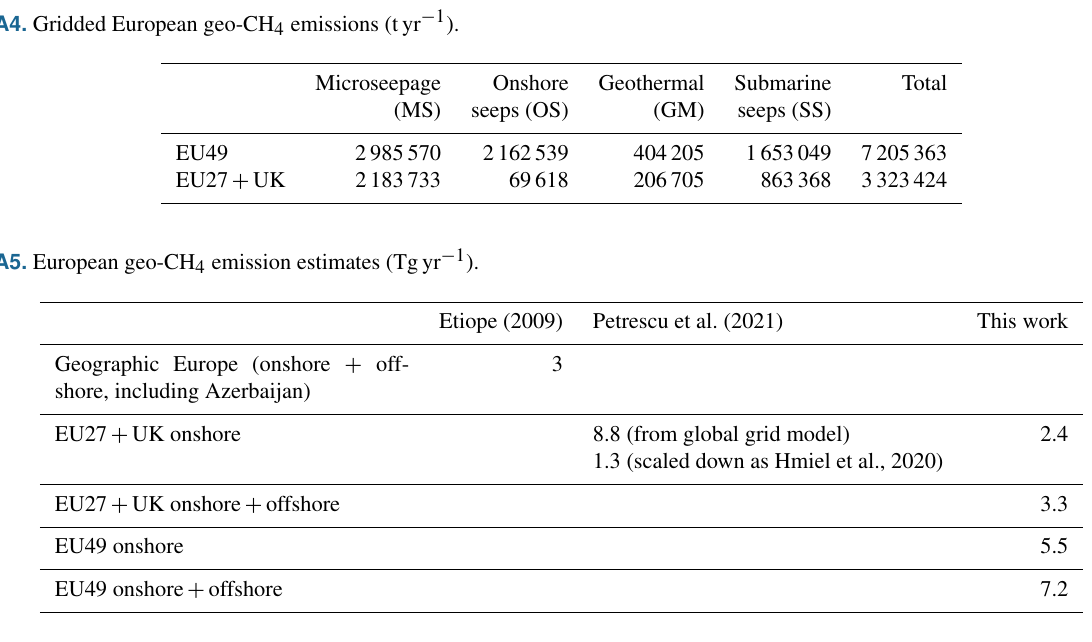
Table A4. Gridded European geo-CH 4 emissions (tyr − 1 ).